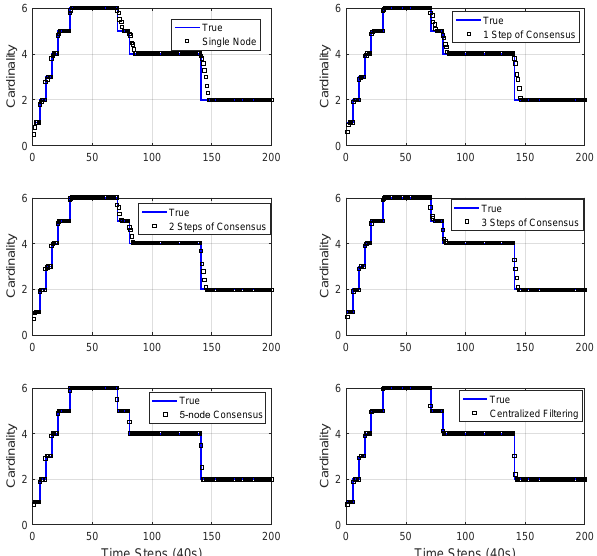
Figure 10. The mean of the estimated cardinality of single-node M δ -GLMB, 1-step consensus, 2-step consensus, 3-step consensus, 5-node consensus, and centralized M δ -GLMB filtering versus